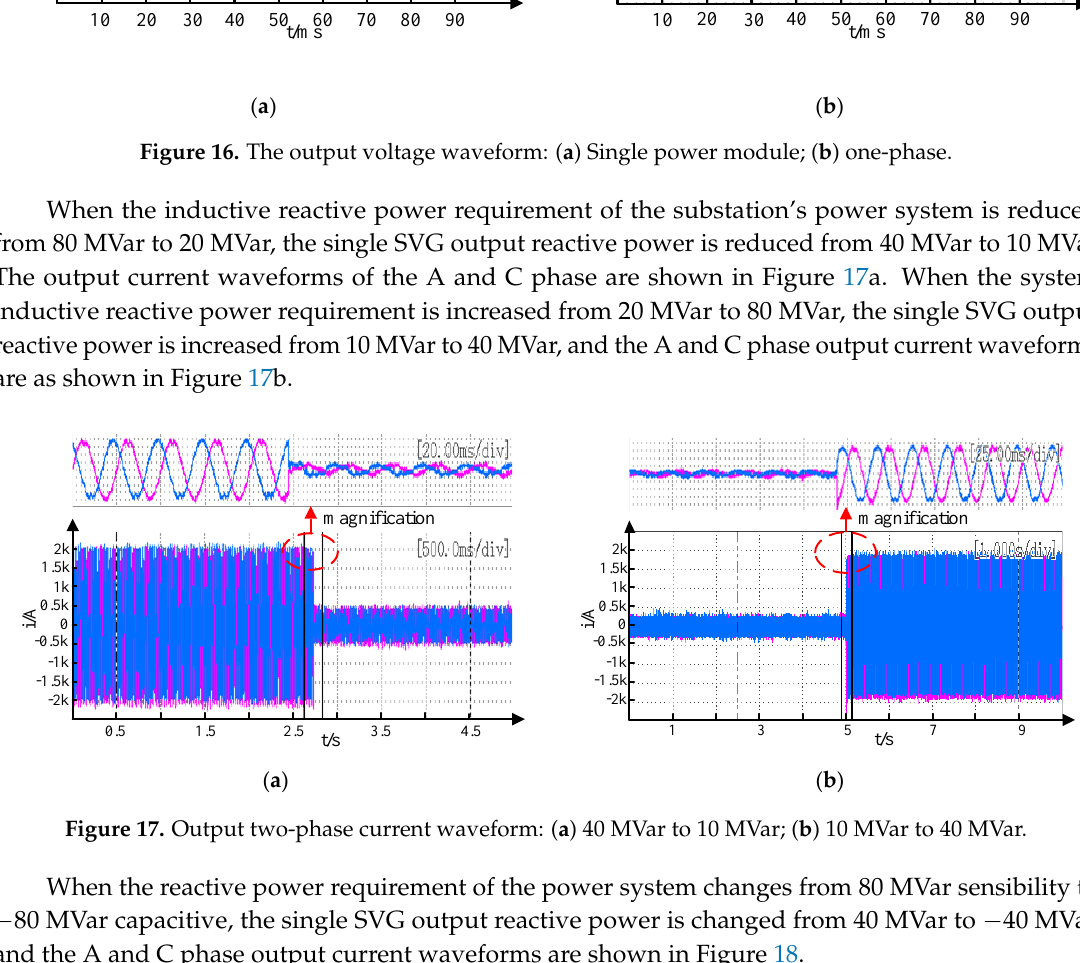
Figure 18. 40 MVar to − 40 MVar output two-phase current waveform.